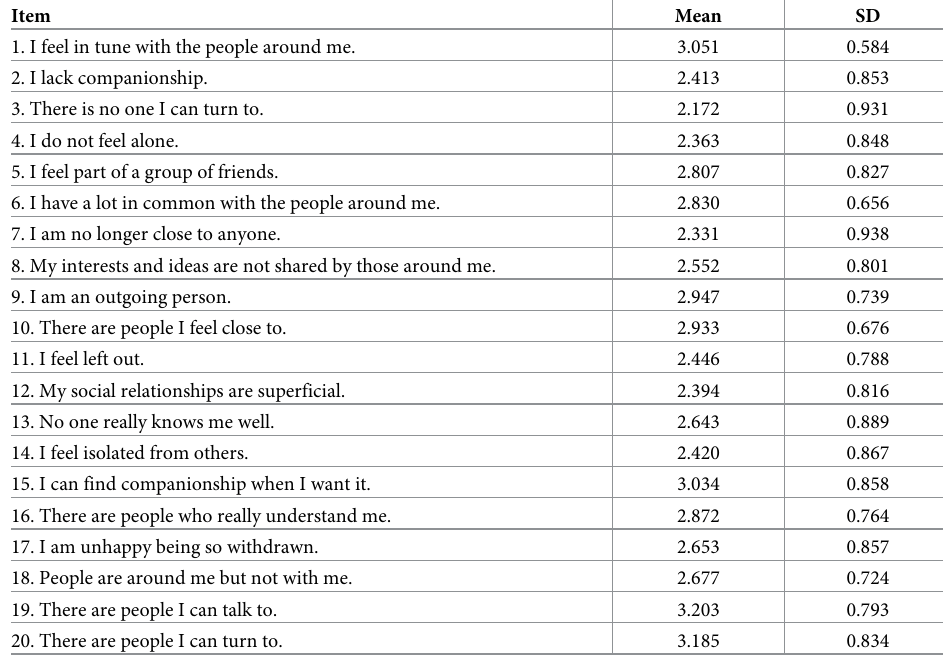
Table 1. Descriptive statistics of questionnaire items (1-4 scale) (Russell, 1996), Sample 1 (nationally representa- tive adults, n = 492). Item